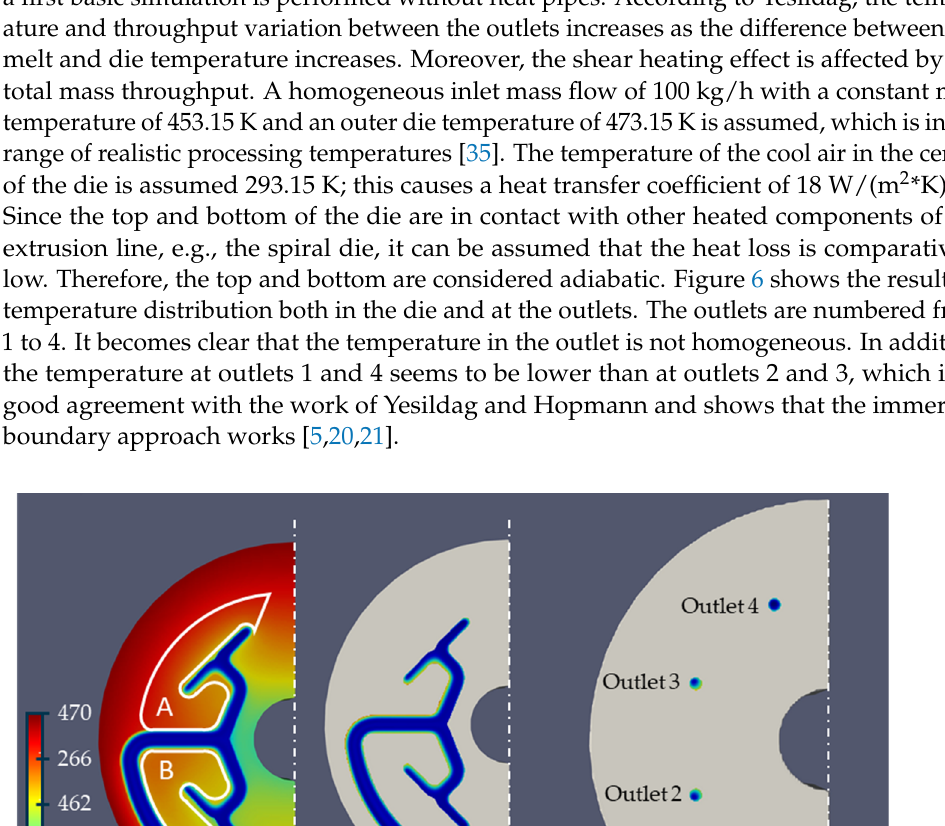
Figure 7. Melt throughput deviation without heat pipes.